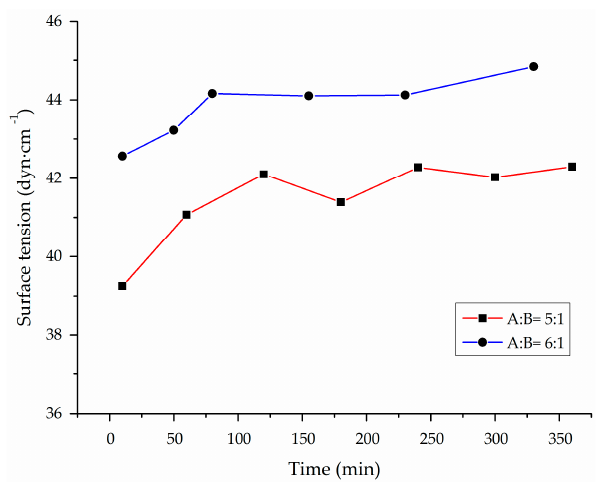
Figure 6. The change curve of surface tension the slurry.